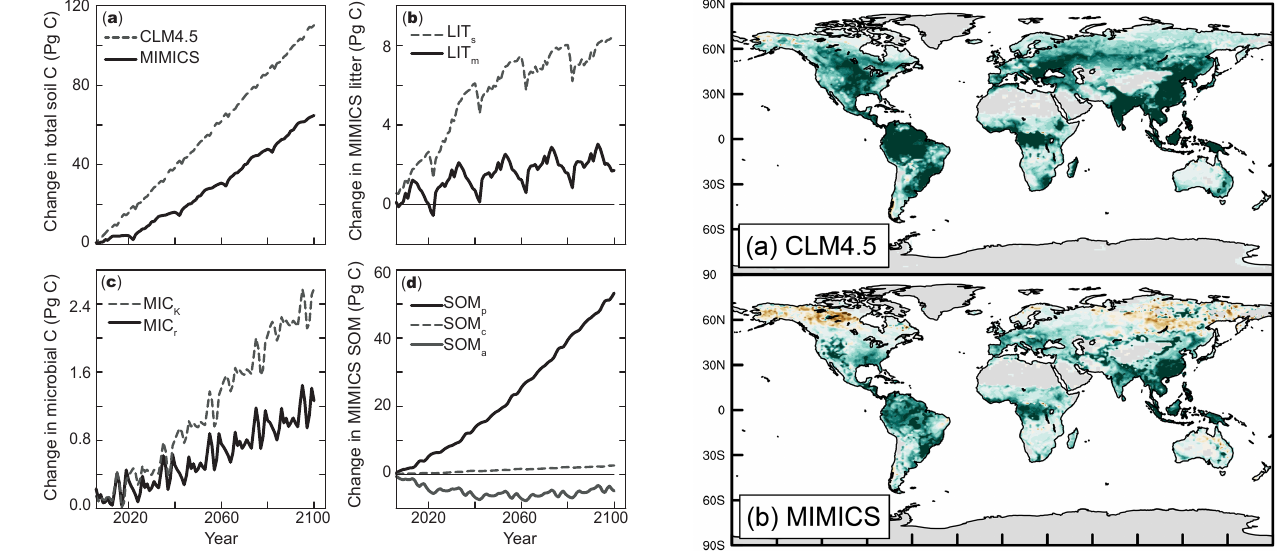
Figure 5. Temporal change in global soil C pools (PgC; 0–100cm) in response to elevated [CO 2 ] and increasing plant productivity throughout the 21st century. (a) Changes in all litter, microbial biomass, and SOM pools simulated by CLM4.5 (dashed line) and MIMICS (black line), totaling 110 and 65PgC globally, respec- tively, for simulations receiving the same C inputs and environ- mental conditions. Specific changes in individual MIMICS pools included (b) Structural and metabolic litter pools (dashed and solid lines, respectively); (c) Oligotrophic and copiotrophic soil microbial biomass pools (dashed and solid lines, respectively); and (d) physi- cally protected, chemically recalcitrant, and available SOM pools (solid black, dashed, and solid grey lines, respectively). Results are from offline (land-only), biogeochemically coupled simula- tions where terrestrial NPP increases from 50PgCy − 1 in 2005 to 64PgCy − 1 by 2100, without concurrent changes in climate. Note differences in the y axes scales among panels.